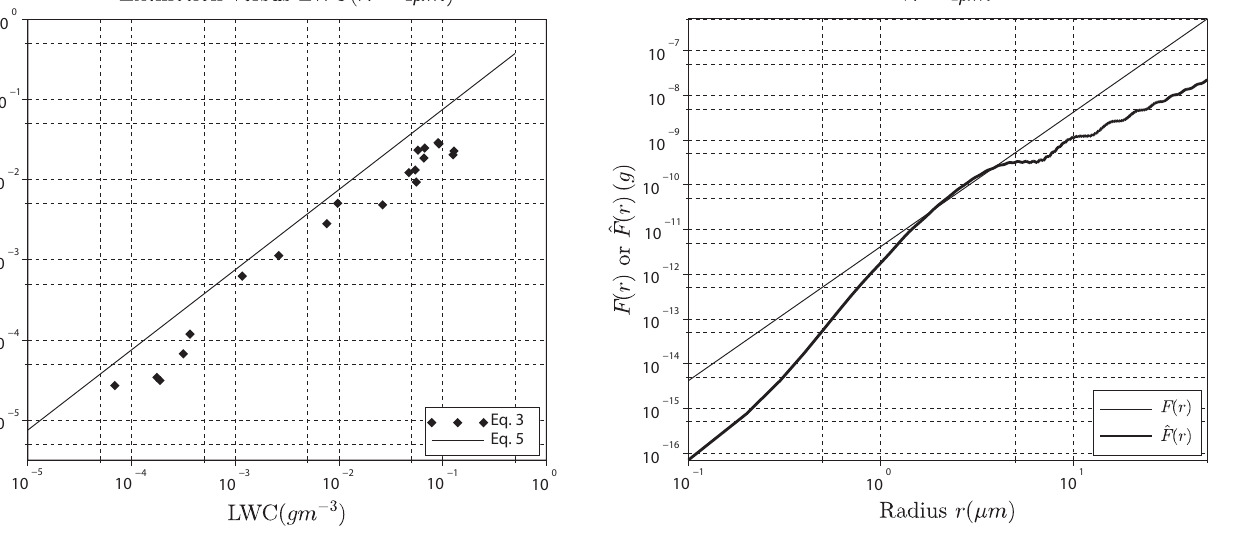
Fig. 5. Functions F(r) and ˆ F(r) defined in Eqs. (6) and (7) as a function of the droplet radius r for λ =